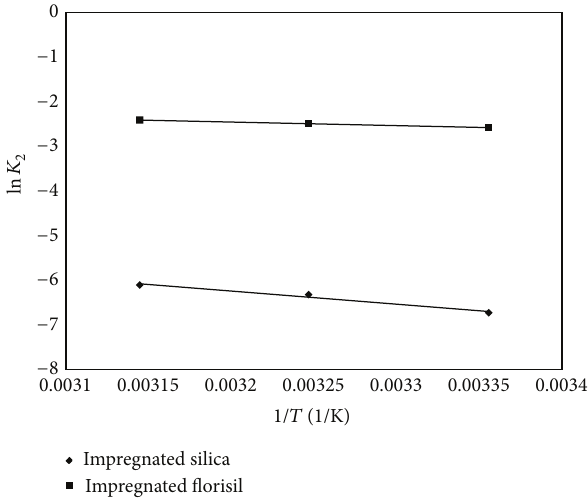
Figure 8: Arrhenius plot of As(V) adsorption onto impregnated silica and florisil.